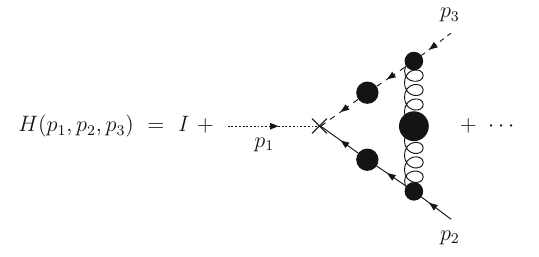
Fig. 11 One-loop dressed perturbation theory